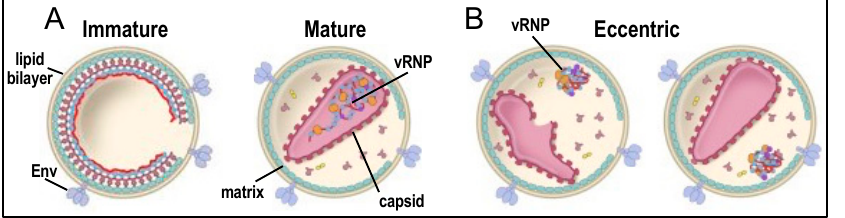
Figure 1. HIV-1 virion particles. ( A ) Schematic of immature and mature virions. Note the vRNP encased in the capsid shell in mature particles. ( B ) Eccentric virions with deformed (left) or closed (right) capsid. Env, envelope glycoproteins. See main text for additional descriptions. Adapted from Ref. [7].